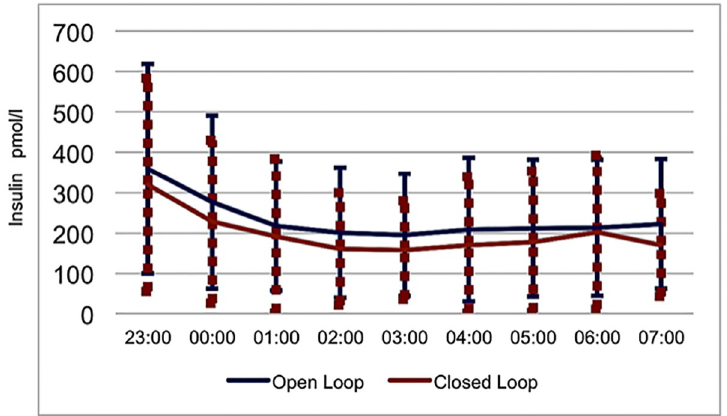
Fig 3. Overnight insulin levels (mean ± (SD) Standard Deviation) in children, treated either with open loop (sensor augmented pump) or closed loop.